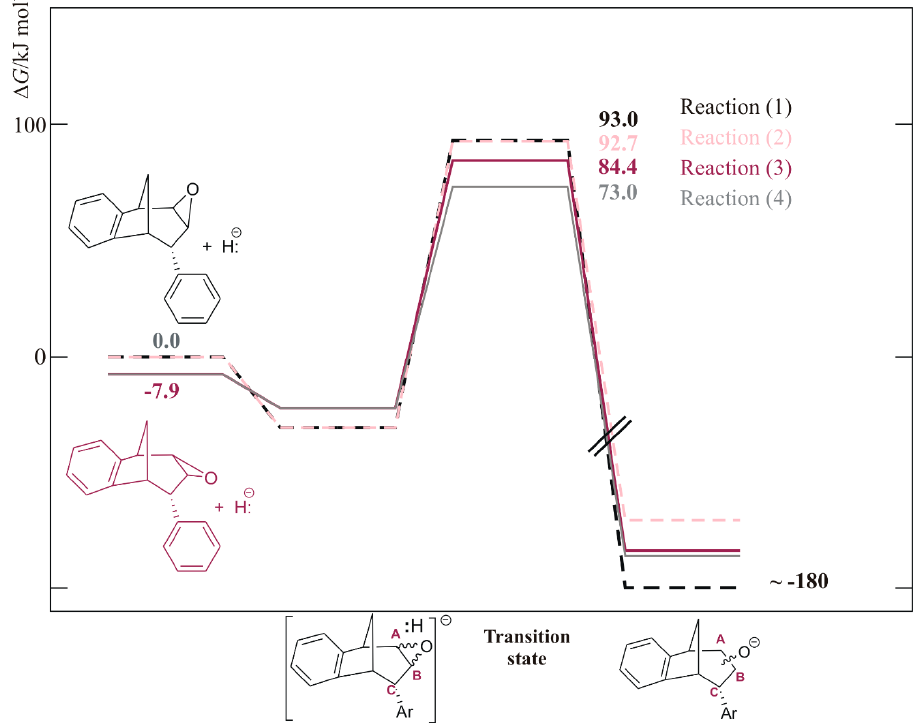
Figure 6. The free energy profile for reactions (1)–(4), calculated at (SMD) / M06-2X / 6-31G(d) level of